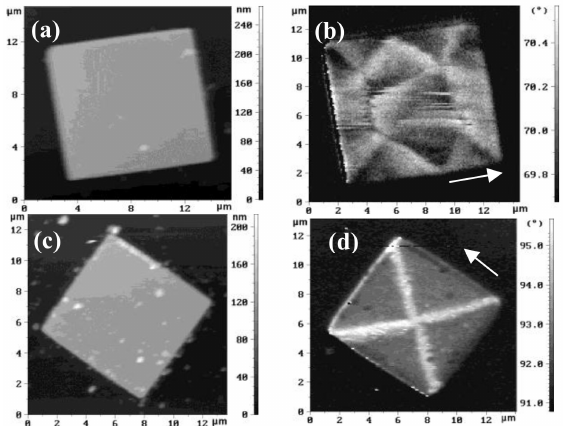
Figure 2. Topography and MFM images of square Fe/ Fe 50 Mn 50 /Mo/R-sapphire structures ( a , b ), and the same ( c , d ) for Fe 50 Mn 50 /Fe/Mo/R-sapphire structures. The arrows indicate the field direction during